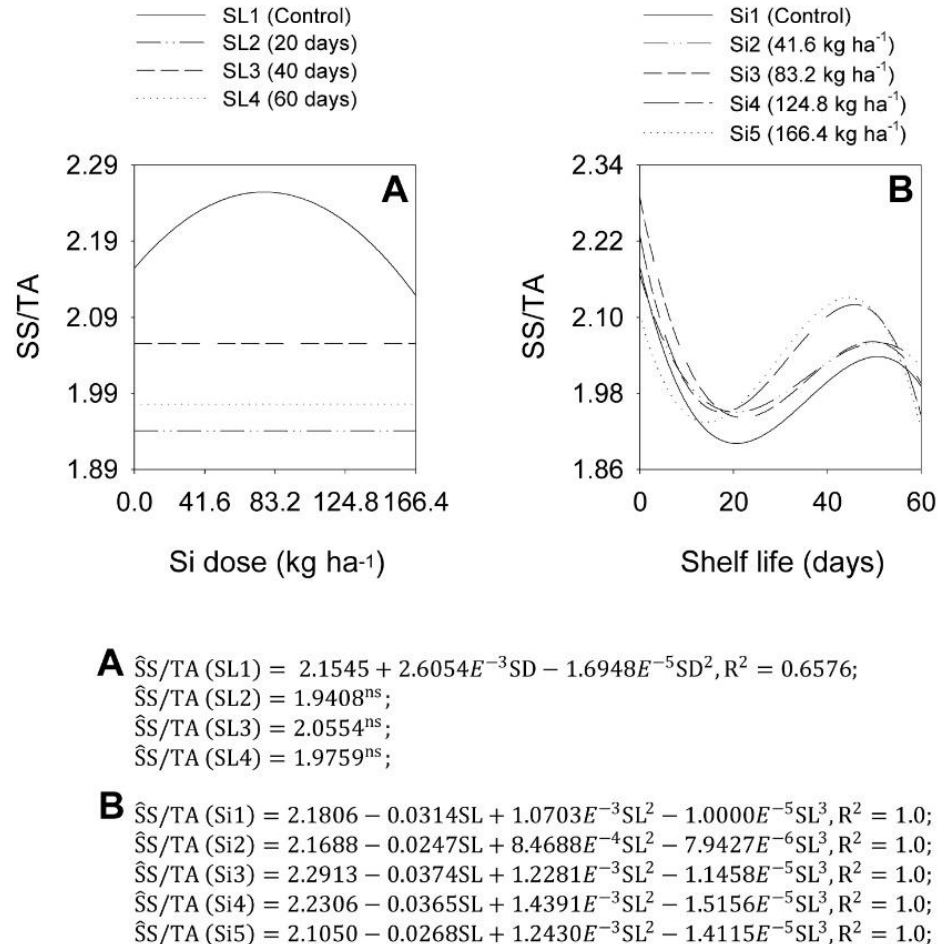
Figure 8. Effect of the interaction between Si dose levels (SD) ( A ) and shelf life (SL) ( B ) on the variable SS/AT in ‘Rio da Antas’ onion bulbs.